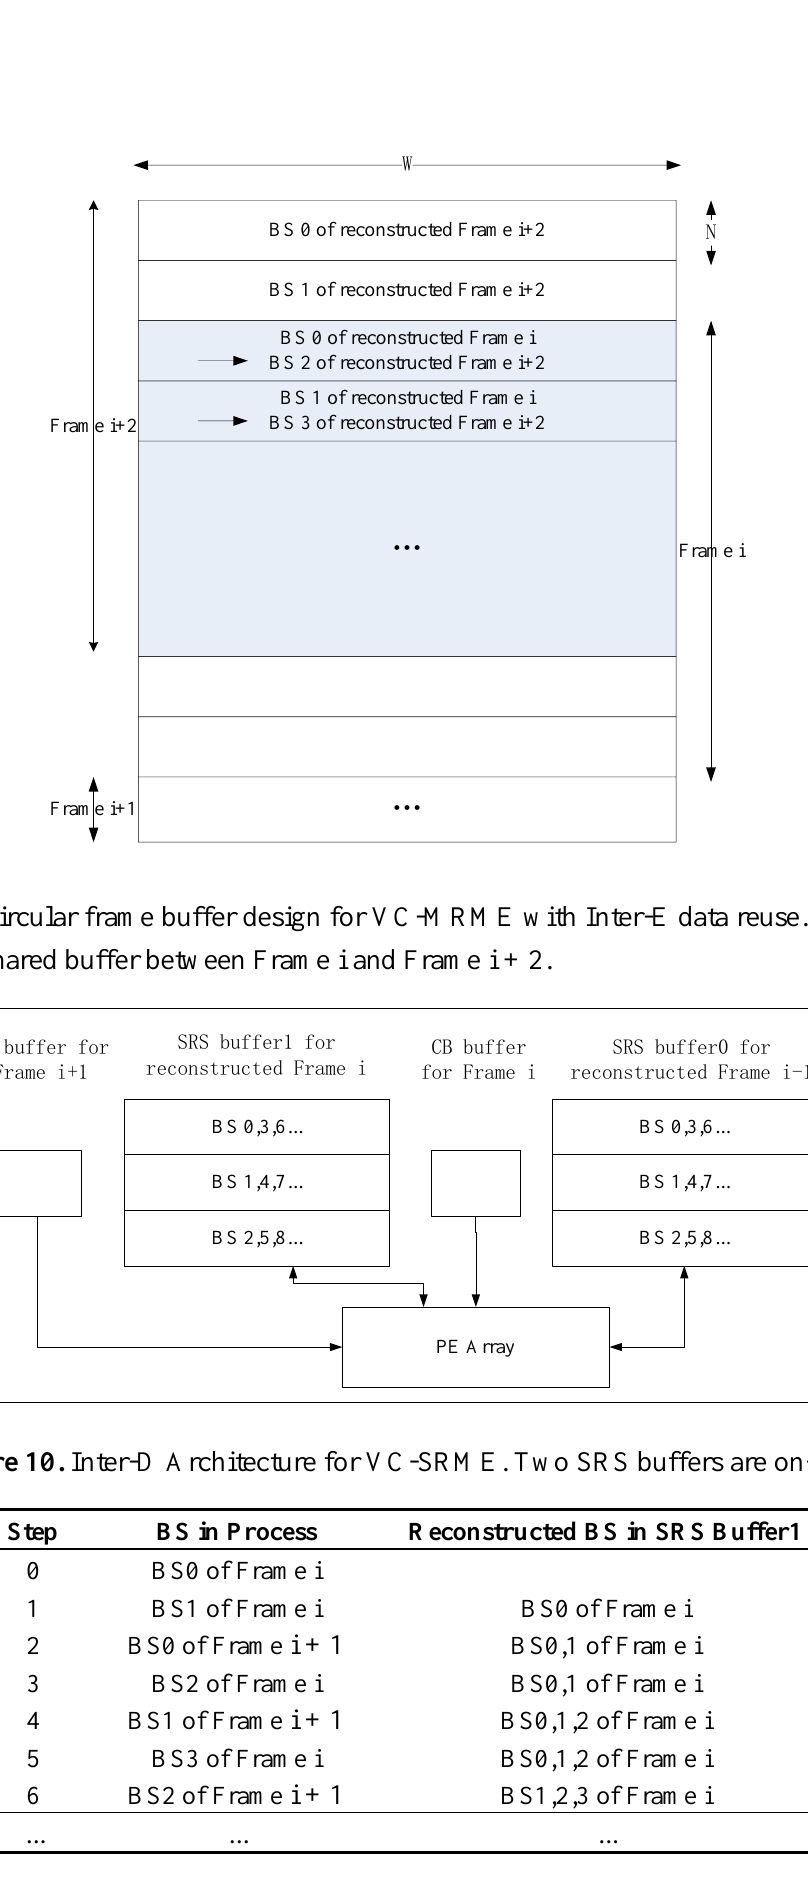
Figure 11. The order of the BS in process for Inter-D of